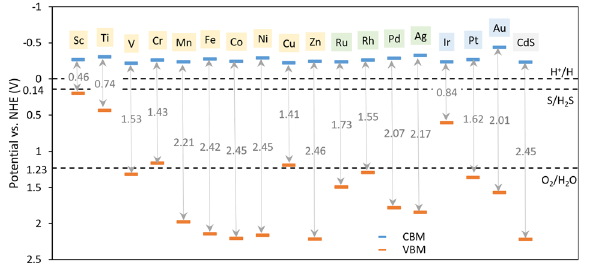
Fig. 4 Relationship between band structure of TM@CdS semi- conductor and redox potentials of H 2 S and H 2 O decomposition computed with the HSE06 hybrid functional. The order of the TM dopant from left to right: 3d series (highlighted in yellow), 4d series (highlighted in green), and 5d series (highlighted in blue). Data are available in Zenodo.